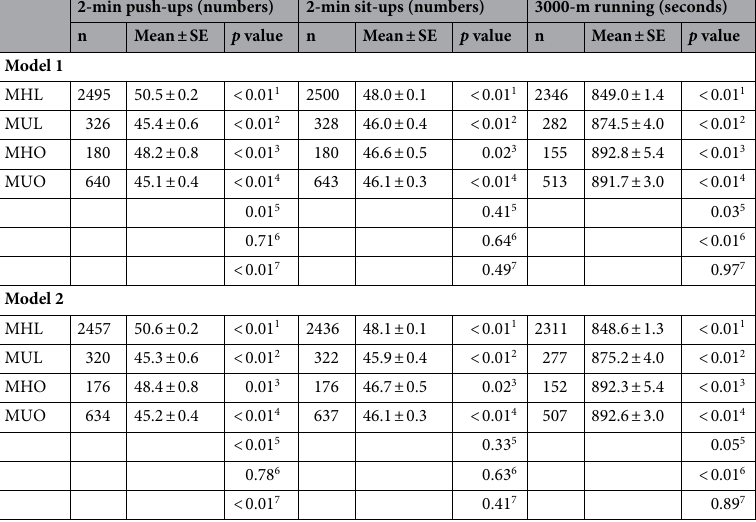
Table 2. Differences in each exercise performance between various metabolic and obese groups. 1 Overall p -value; 2 MUL versus MHL; 3 MHO versus MHL; 4 MHO versus MHL; 5 MHO versus MUL; 6 MUO versus MUL; 7 MHO versus MUO. Mean ± SE (standard error) for each exercise performance estimated using analysis of covariance with adjustments for Model 1: age and specialty and Model 2: the covariates in Model 1, physical activity, current alcohol drinking and current tobacco smoking. MHL, metabolically healthy lean, defined as body mass index < 27.5 kg/m 2 and absence of two major components of the metabolic syndrome, according to the International Diabetes Federation criteria for Asian male adults; MHO, metabolically healthy obesity defined as body mass index ≥ 27.5 kg/m 2 and absence of two major components of the metabolic syndrome; MUL, metabolically unhealthy lean defined as body mass index < 27.5 kg/m 2 and presence of at least two major components of the metabolic syndrome; MUO, metabolically unhealthy obesity defined as body mass index ≥ 27.5 kg/m 2 and presence of at least two major components of the metabolic